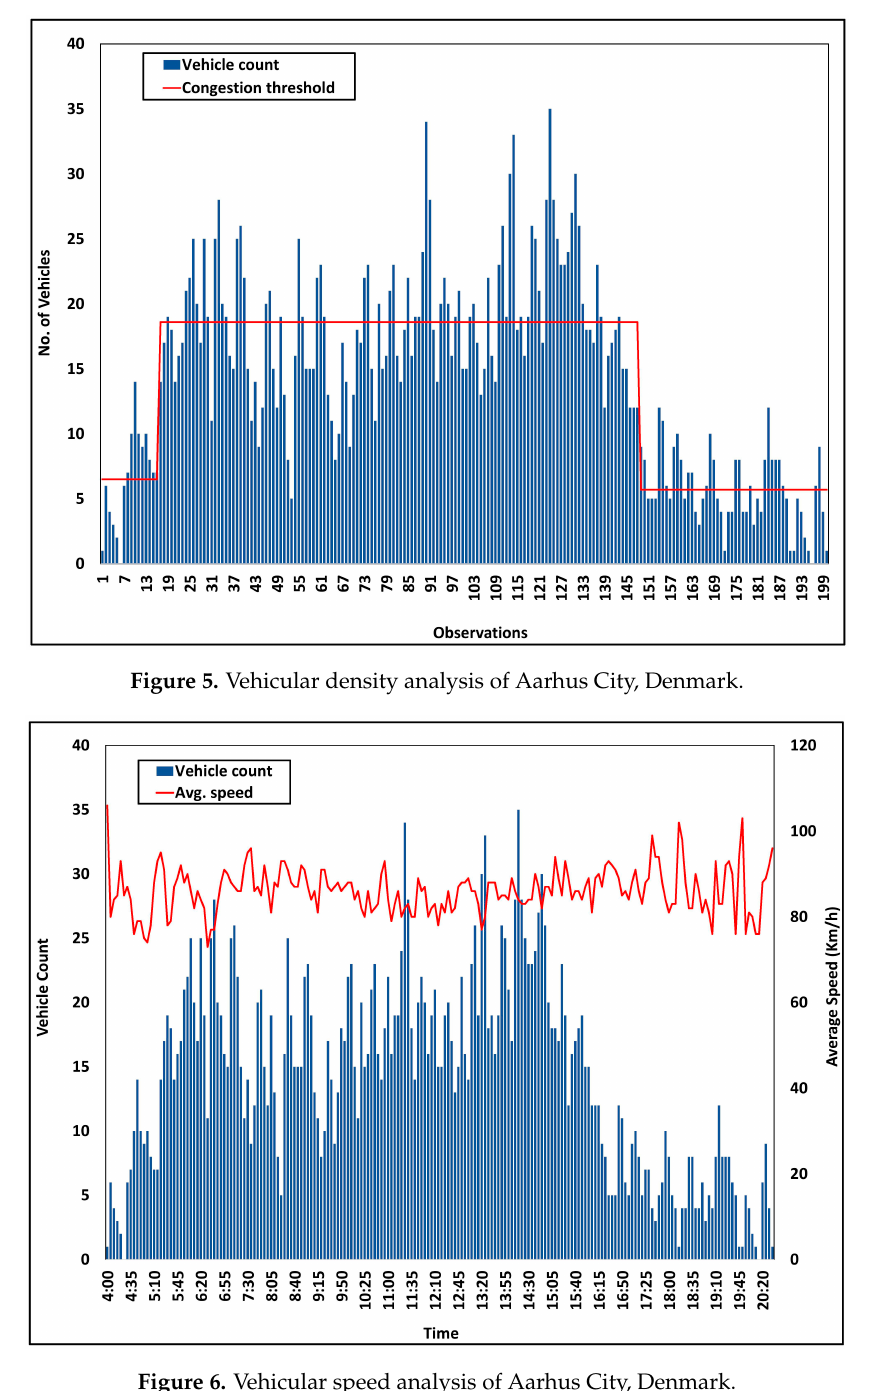
Figure 6. Vehicular speed analysis of Aarhus City, Denmark.